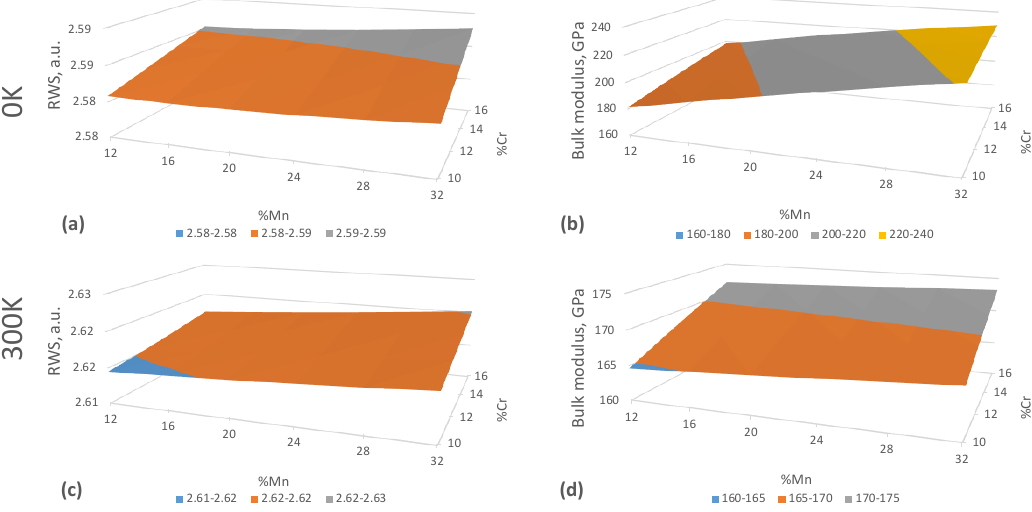
Figure 2. Equilibrium Wigner-Seitz radii (RWS, in a.u.) at 0 K ( a ) and at 300 K ( c ) and the bulk modulus at 0 K ( b ) and at 300 K ( d ) in PM fcc random FeMnCr